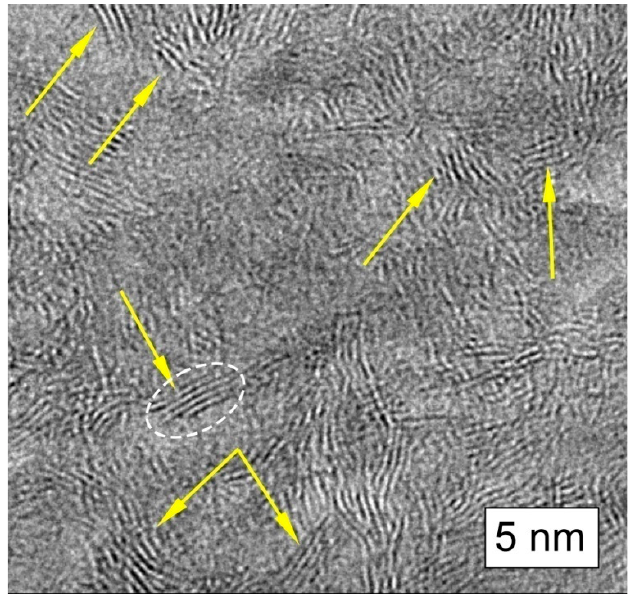
Figure 6. Chaotically oriented stacks of graphene layers in shungite carbon (indicated by yellow arrow).